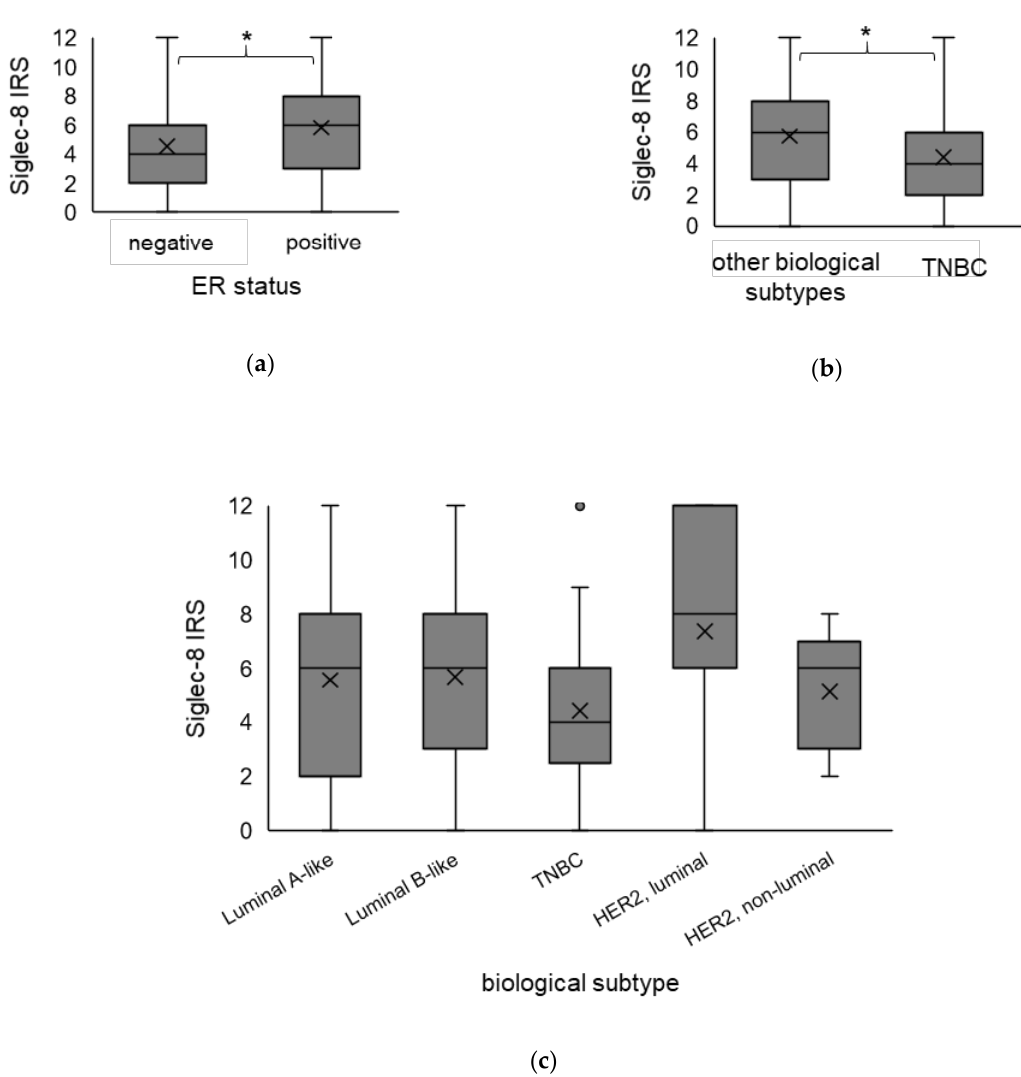
Figure 3. Association of Siglec-8 expression with the biological subtype. Boxplots of the mean IRS of Siglec-8 staining ± SD dependent on ER status ( a ), in TNBC compared to all other biological subtypes ( b ) and in the specific biological subtypes in detail ( c ), are shown. ER-positive tumors show a higher Siglec-8 expression than ER-negative tumors. Siglec-8 expression in TNBC is significantly lower than in the other biological subtypes. IRS = immune reactivity score. ER = estrogen receptor. TNBC = triple-negative breast cancer. HER2 = human epidermal growth factor receptor 2. SD = standard deviation. * indicates a p -value < 0.05. The dot in the Figure 3c indicates an outlier value.